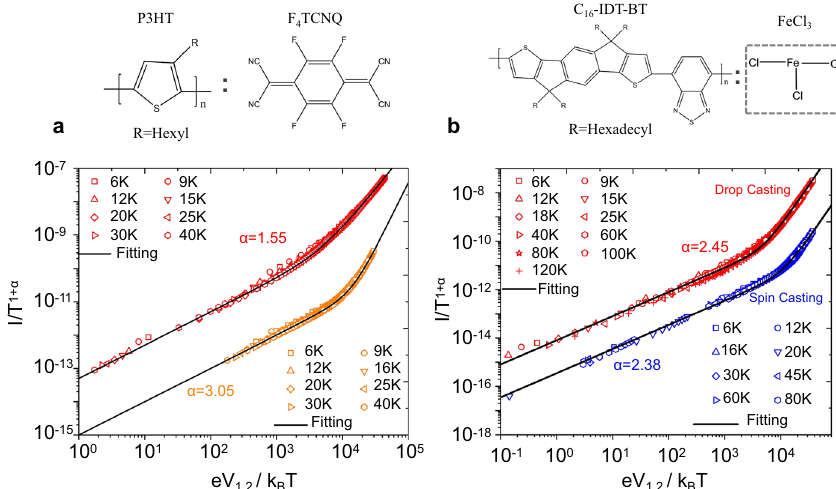
Fig. 6 Scaling of nonlinear transport behavior of doped conducting polymer samples based on P3HT and IDT-BT. a Crystalline polymer of Poly(3- hexylthiophene) (P3HT) doped with F 4 TCNQ. Fitting between I(V, T) and the curves depicted by Eq. (1), for HC P3HT sample (red) and PC one (orange), which are displayed in double logarithmic coordinates. Structural formulas of P3HT and dopant F 4 TCNQ are shown at top. b Noncrystalline polymer of indacenodithiophene-benzothiadiazole (IDT-BT) doped with FeCl 3 . Fitting between I(V, T) and the curves depicted by Eq. (1), for drop casting IDT-BT sample (red) and spin casting one (blue), which are displayed in double logarithmic coordinates. Structural formulas of IDT-BT and dopant FeCl 3 are shown at top. Values of parameters α are obtained via the fi